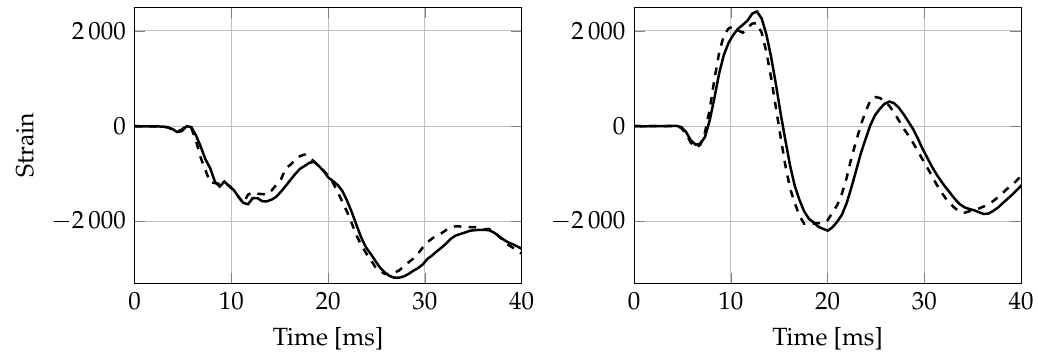
Figure 8. Deformation over time of a fibreglass/vinylester wedge 2mm thick with deadrise angle of 20 ◦ entering the water at 6.7 m/s. Time advances left to right, top to bottom.